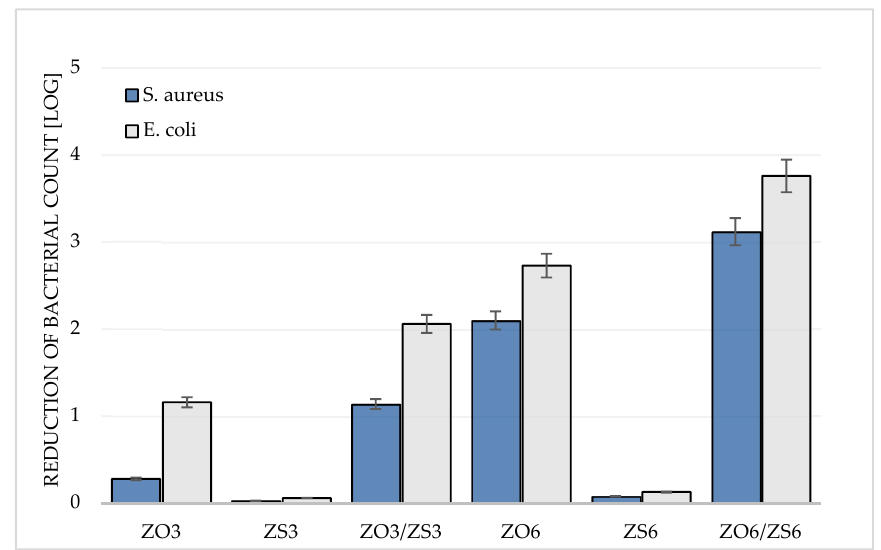
Figure 3. Comparison of the logarithmic reduction of bacteria cells number after incubation with PE films containing a masterbatch with zinc oxide (ZO) and / or zinc stearate (ZS) with respect to the Control sample after 24 h incubation.